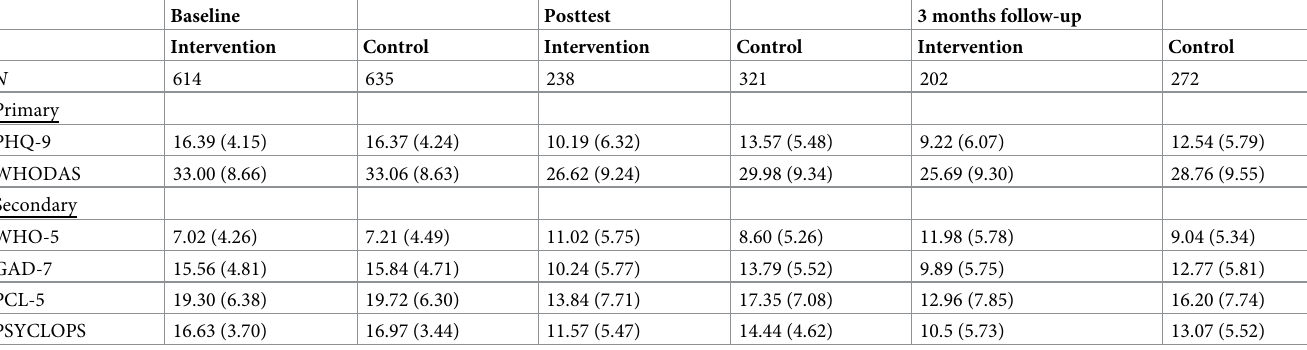
Table 2. Inferential statistics of treatment outcome measures for complete cases: means, standard deviation, and N . Baseline Posttest 3 months